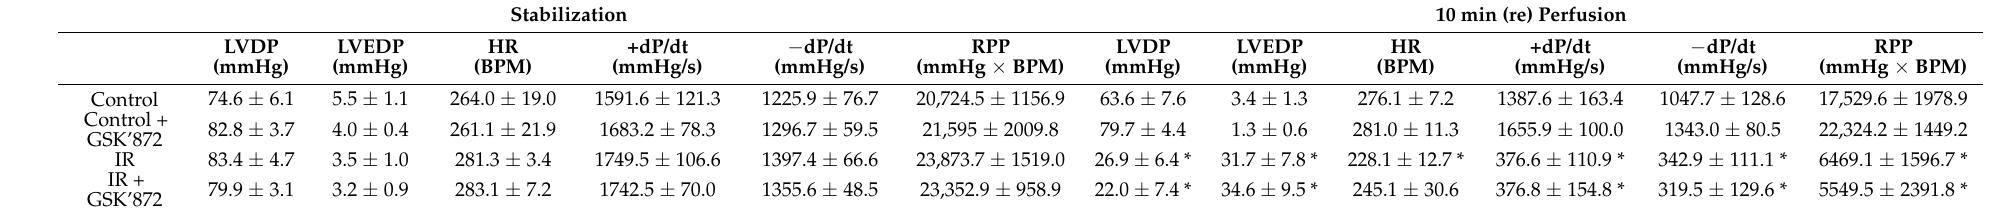
Table 1. Hemodynamic parameters of isolated rat hearts. Data are presented as ± SEM; * p < 0.05. MMA—mixed-model